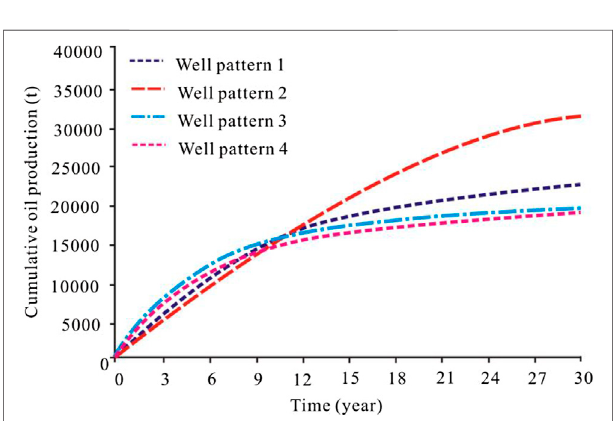
FIGURE 13 | Changes in cumulative oil production of different injection- production well patterns.